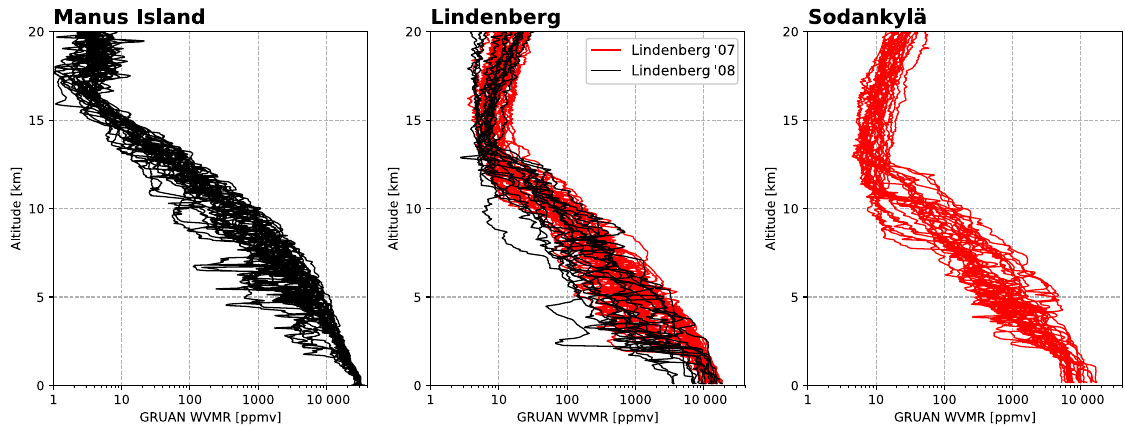
Figure 2. Vertical H 2 O profiles as measured by the 100 different GRUAN-processed Vaisala RS92 radiosondes, from Manus Island, Linden- berg, and Sodankylä, used for our study. Black lines indicate radiosonde data ensembles that cover all seasons (Manus Island and Lindenberg 2008), and red lines indicate ensembles that cover the summer season